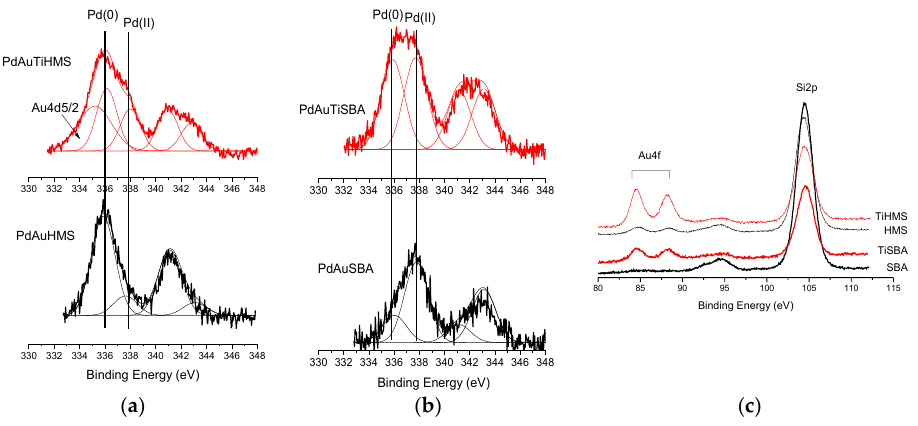
Figure 6. XPS spectra of PdAu supported silica catalysts on HMS and SBA as is or Ti-doped. ( a ) Pd3d on HMS/ TiHMS ( b ) Pd3d on SBA/TiSBA ( c ) Au4f and Si2p on silica